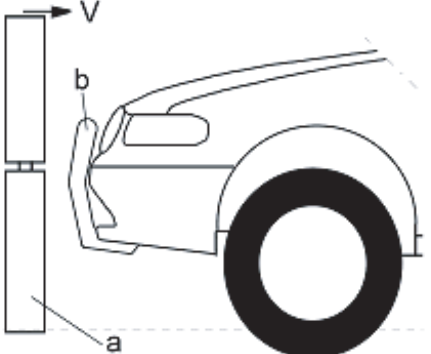
Fig. 1. Lower legform impact testing. (a) Legform impactor, (b) Frontal protection system, V – velocity of